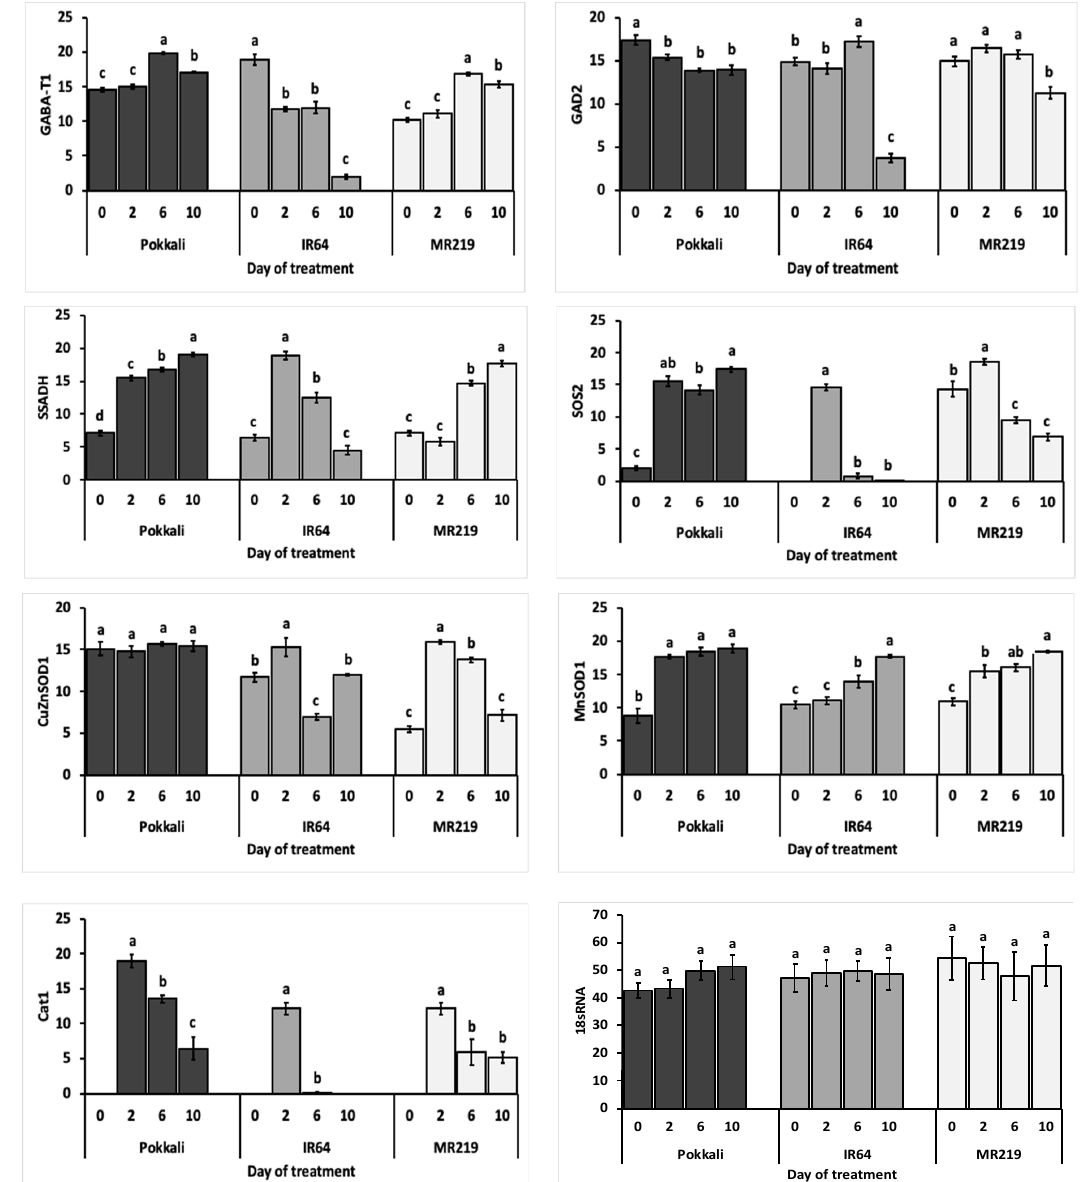
Figure 5. Gene expression in Pokkali, IR64, and MR219 at four different time points under salinity treatment. The small letter at the top of the bars indicates that there are significant differences between different time points for the same variety based on the DNMRT analytical method with a p -value of 0.05. Error bar = Standard deviations (SD) of the